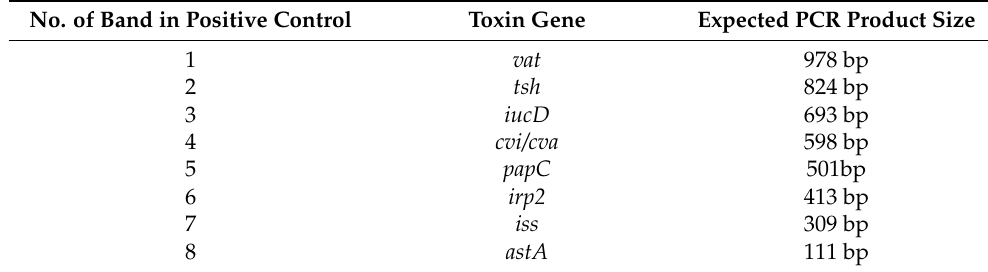
Table 4. The expected product sizes of the toxin genes of